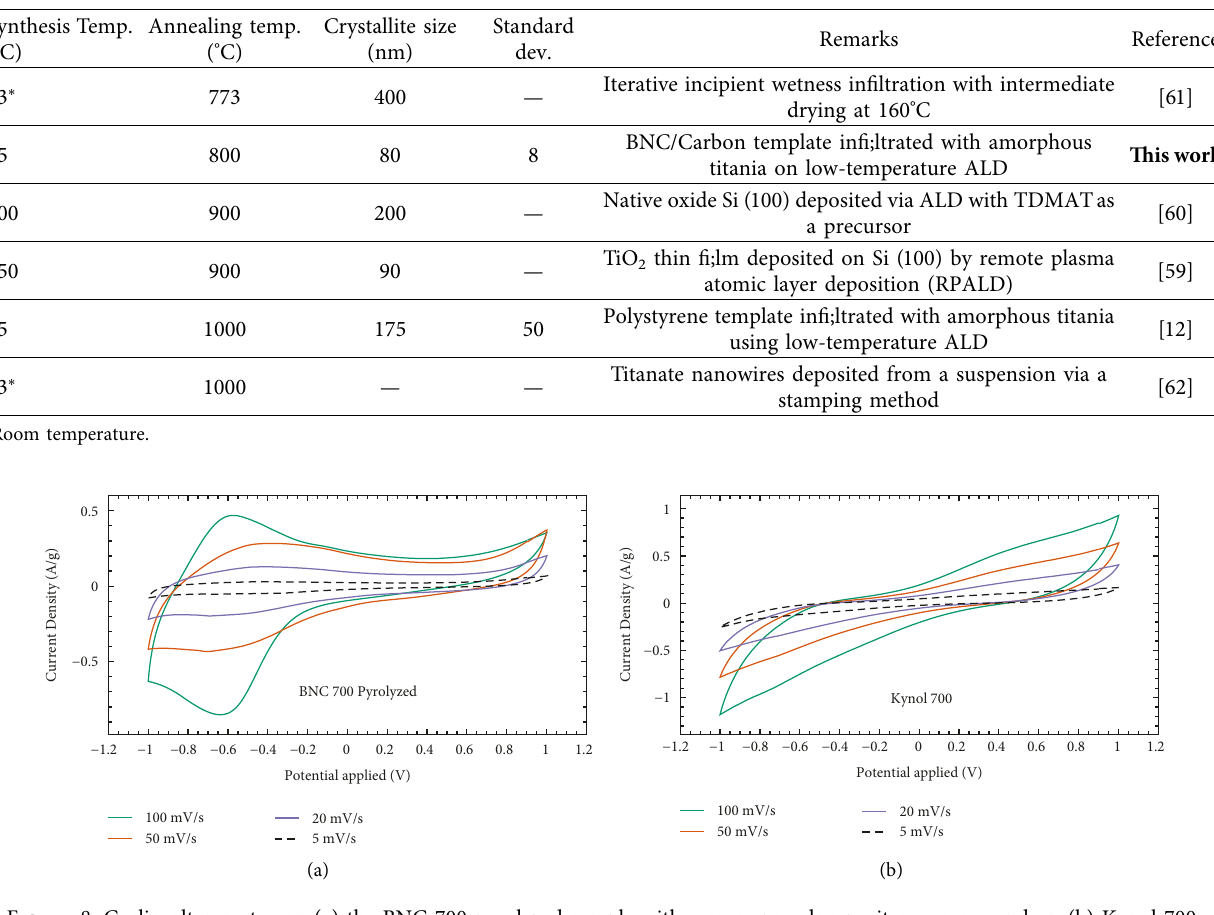
Figure 8: Cyclicvoltammetry on (a) the BNC 700 pyrolyzed sample with a more pseudocapacitance curve and on (b) Kynol